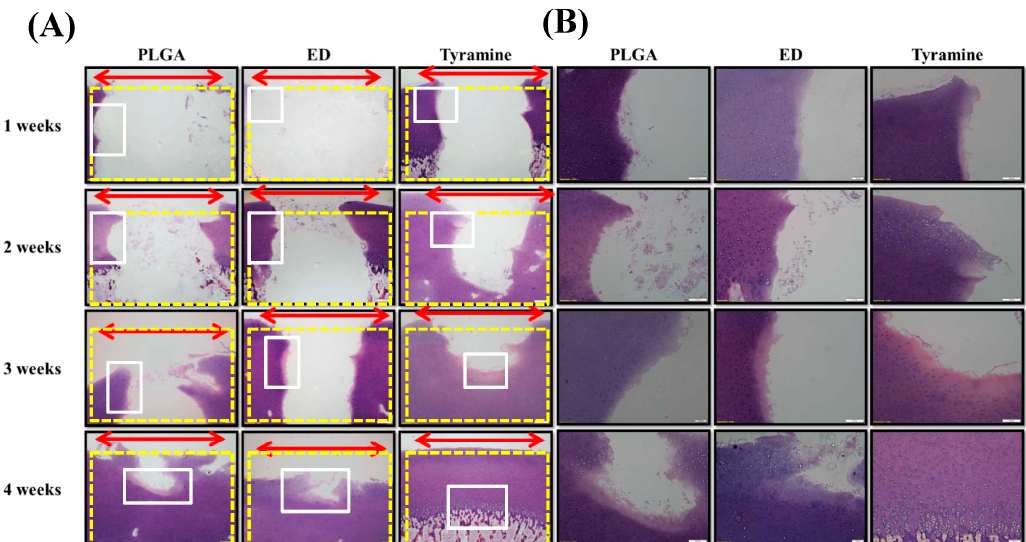
Figure 5. Histological analysis of co-cultured bilayered PLGA scaffold and porcine osteochondral plug by hematoxylin and eosin staining. ( A ) Magnification: 40 × ; scale bar: 200 µ m. ( B ) Magnification: 100 × ; scale bar: 100 µ m. Red double-headed arrows ( ←→ ) indicate the defect area after tissue regeneration. Yellow dotted boxes indicate the defect area before tissue regeneration. White boxes indicate that the images of tissue regeneration area were